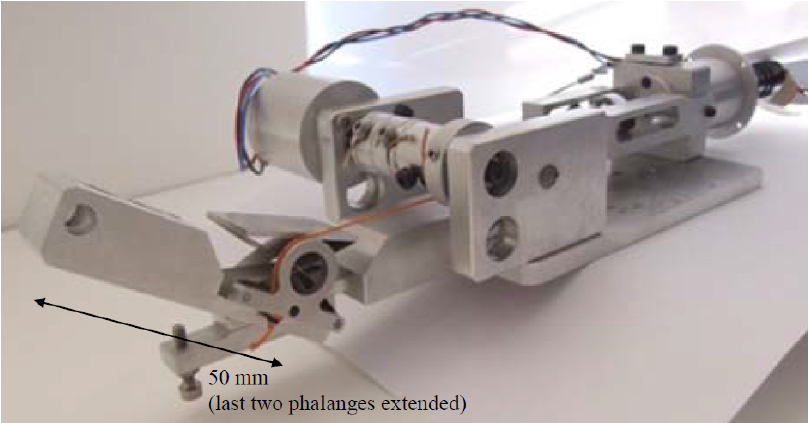
Finger prototype integrating the inter-phalangeal rotational pivot and the tendon-driven backdrivable